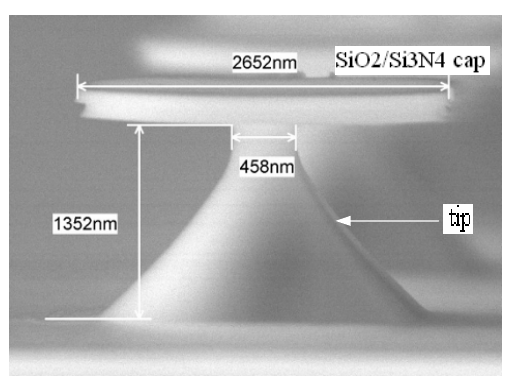
Figure 2. The SEM diagram of the single